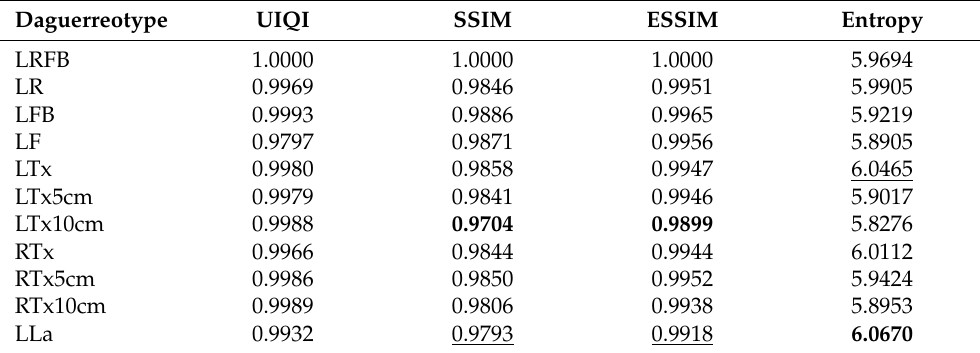
Table 3. Daguerreotype. Comparison of images scanned in different scan modes with a reference image scanned in LRFB mode.